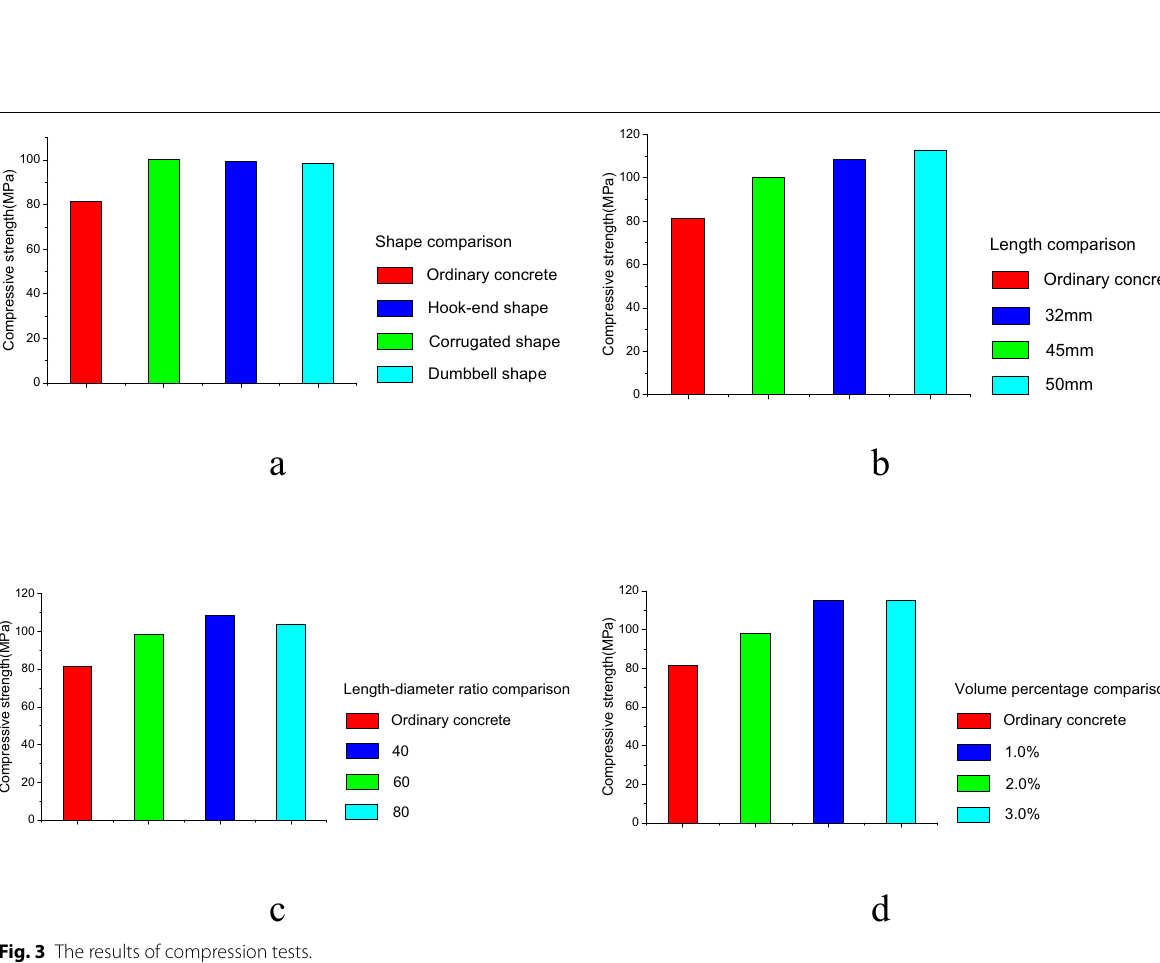
Fig. 3 The results of compression